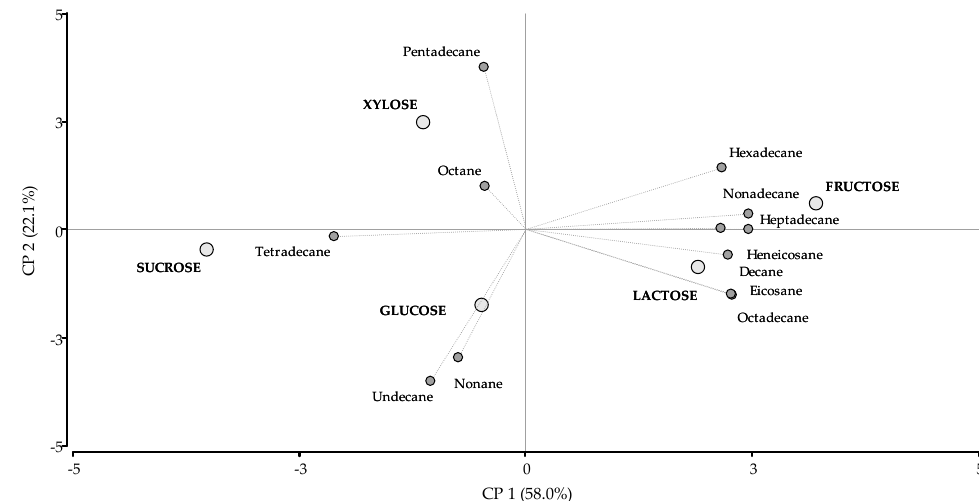
Figure 2. PCA of Straight-chain alkanes. A total of 17 variables were included: 12 VOCs (dark grey circles) and 5 carbon sources (light grey circles). The first two principal components accounted for 58.0% and 22.1% of the total variation, respectively.